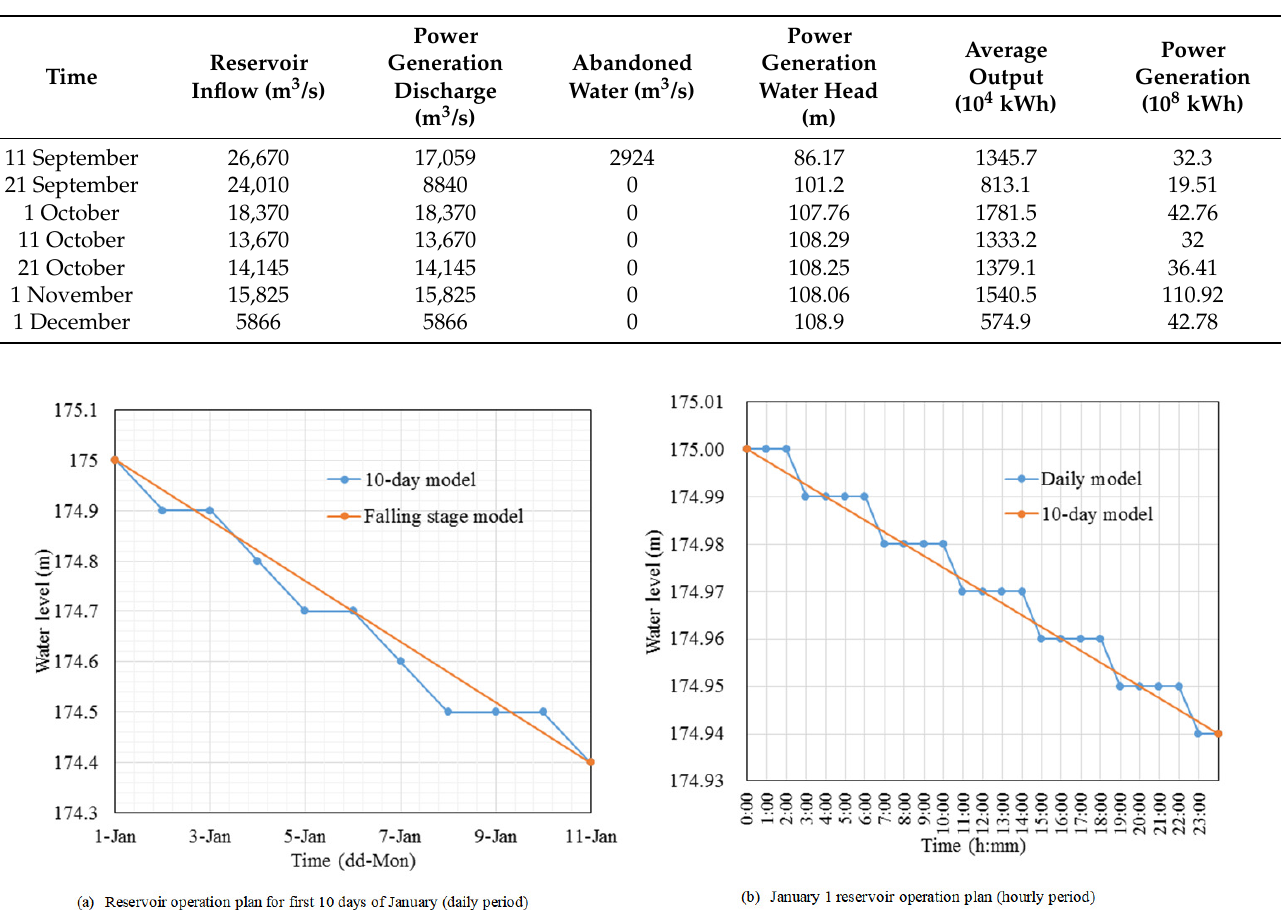
Figure 12. TG reservoir operation plans. Table 8. Implementation effect statistics of January operation plan for TG reservoir (10-day